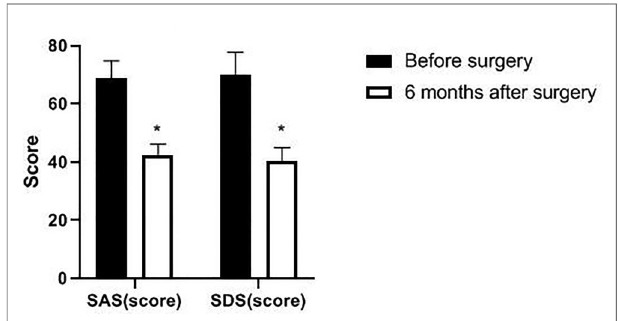
FIGURE 10 | Changes of SAS and SDS scores in patients before and after surgery. Note: compared with before surgery, *